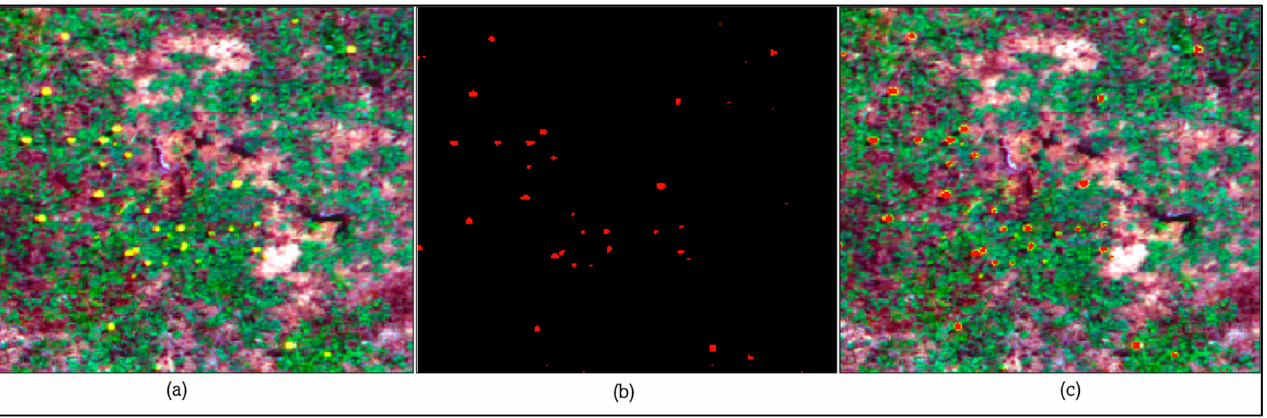
Figure 9. Confusion matrix for validation of different machine learning models for flower detection.